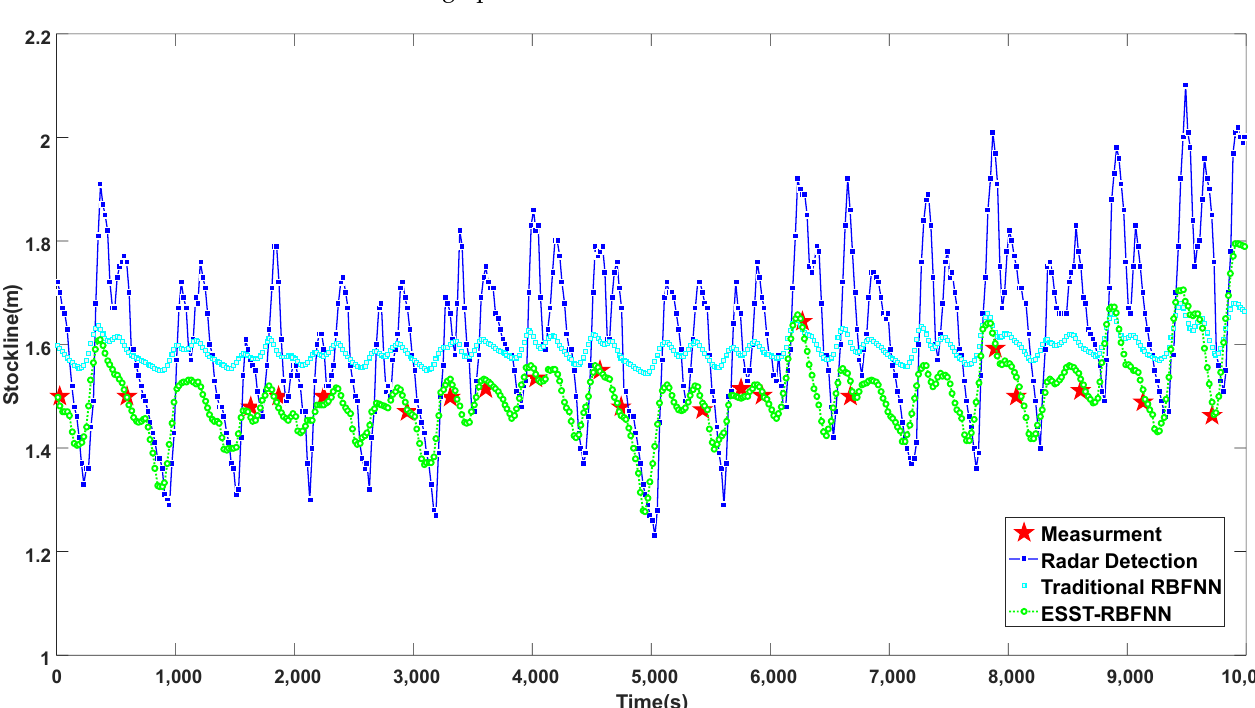
Figure 9. Comparison chart of different methods for measuring blast furnace burden level under normal working conditions.